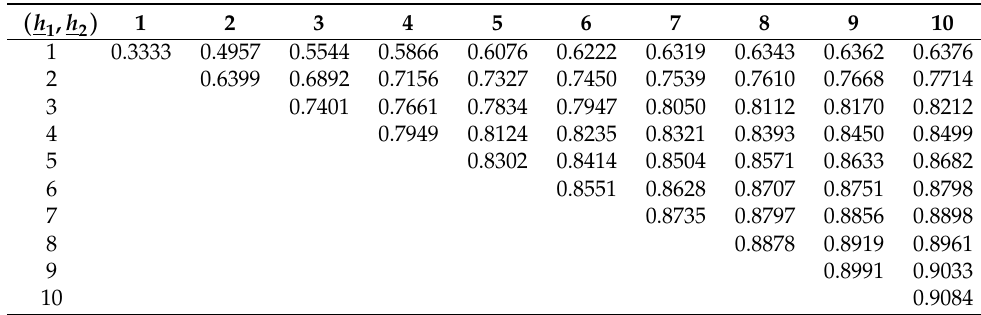
Table 1. The 100 values of ρ max ( h 1 , h 2 ) for 1 ≤ h 1 , h 2 ≤